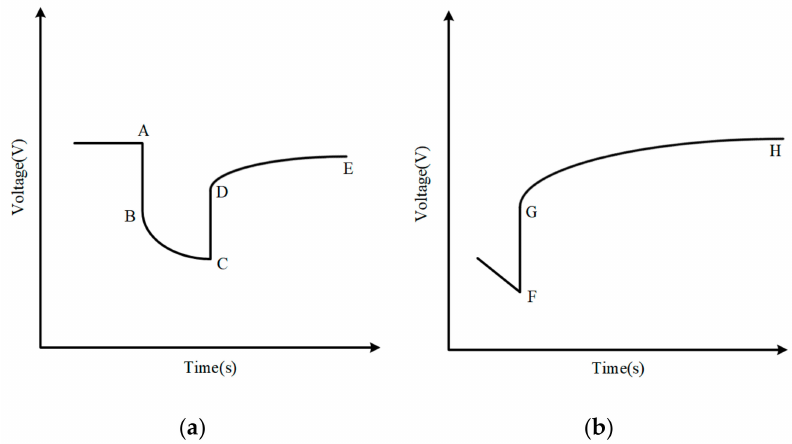
Figure 2. ( a ) Voltage response curve under pulse discharge; ( b ) voltage response curve under long discharge